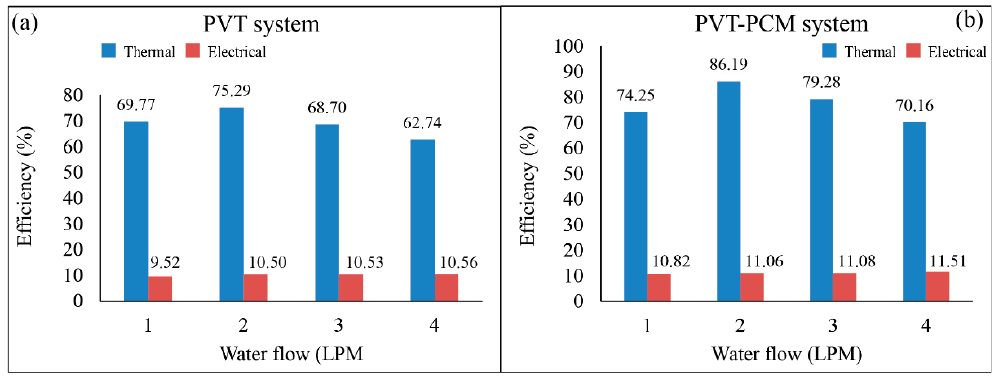
Figure 7. Average energy efficiency comparison performance of ( a ) PVT and ( b ) PVT-PCM for different mass flow rates.